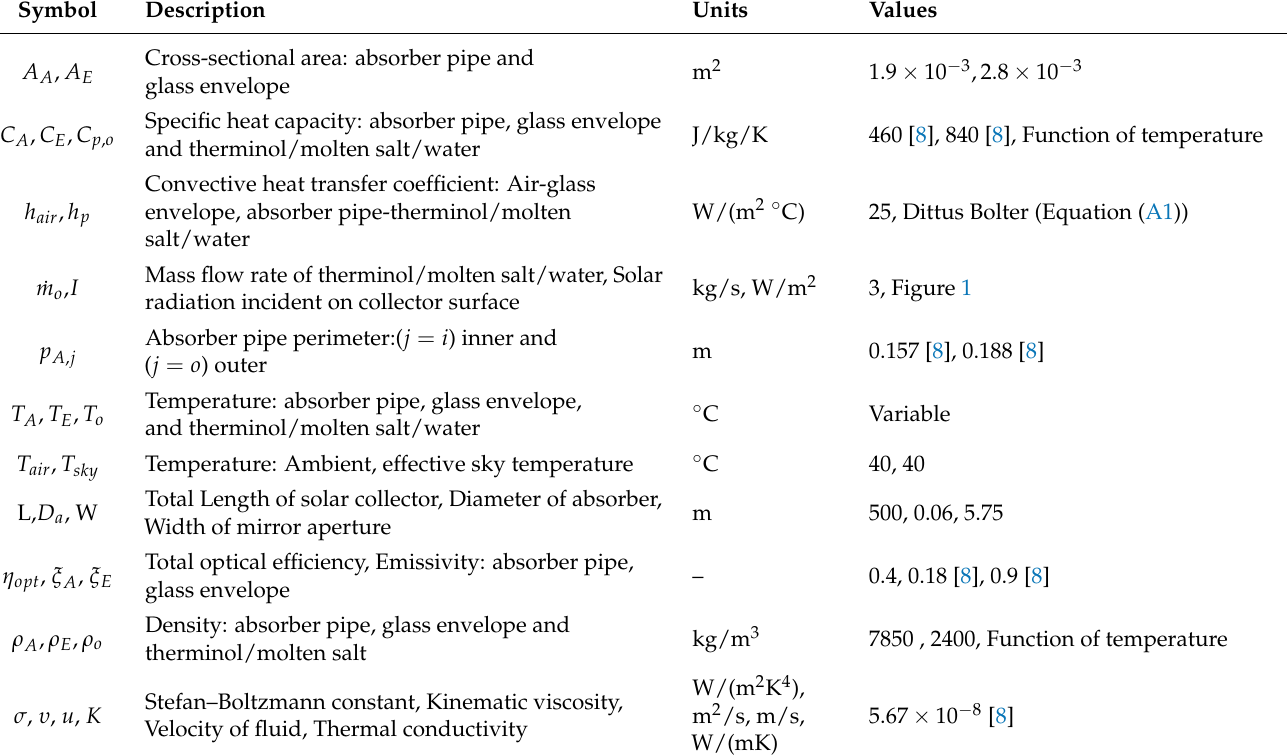
Table 1. PTC: Notation and values of